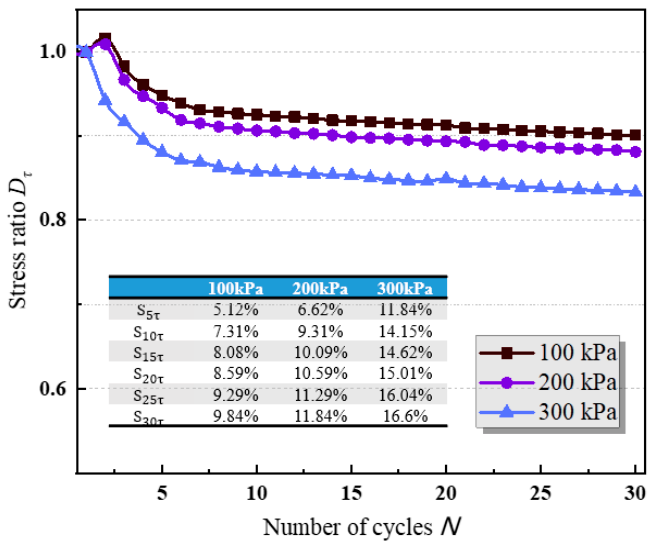
Figure 9. Stress ratio–number of cycles curve under different normal stress levels.